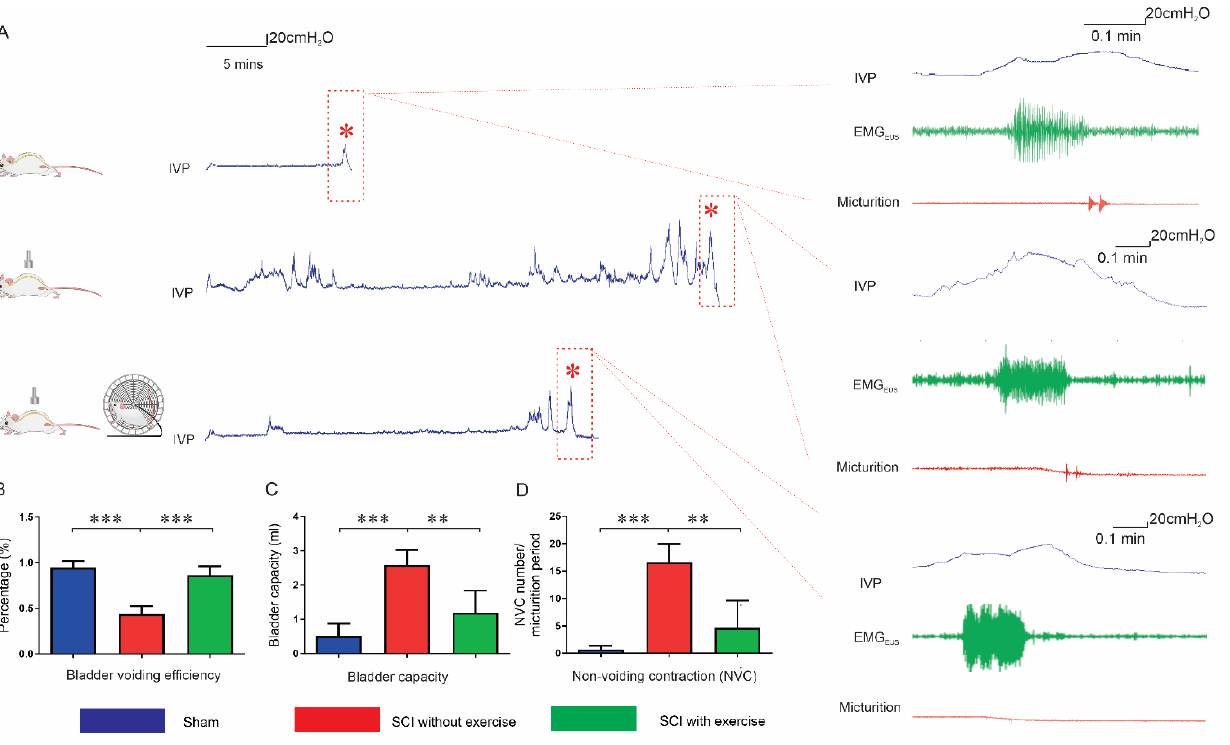
Figure 3. Locomotor exercise improves bladder overactivity and voiding efficiency. ( A ) Representa- tive tracing of raw recordings in a single-bladder CMG assessment. Red asterisks, peak intravesical pressure (IVP) associated with micturition. High magnification of IVP trace within red dashed rectan- gle shown in right panel: (top to bottom) sham, SCI without exercise, and SCI with exercise. Each IVP trace (blue) was accompanied by a simultaneous recording of EMG EUS (green), and the event of micturition (red) recorded by metabolic cage. Results indicate that, compared with SCI without exercise, exercise significantly reduces latency to induce voiding ( A ). Bladder voiding efficiency, bladder capacity, and nonvoiding contraction (NVC) were improved in the exercise group, shown in the bar graphs of ( B – D ). **: p < 0.01; ***: p <